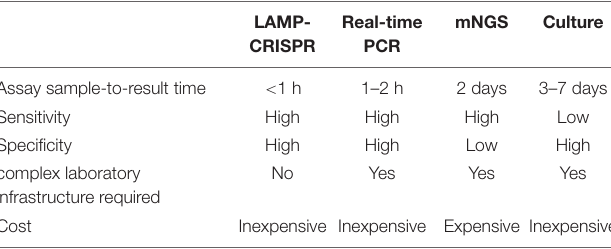
TABLE 3 | Comparison of the LAMP-CRISPR assay to real-time PCR, mNGS, and the reference